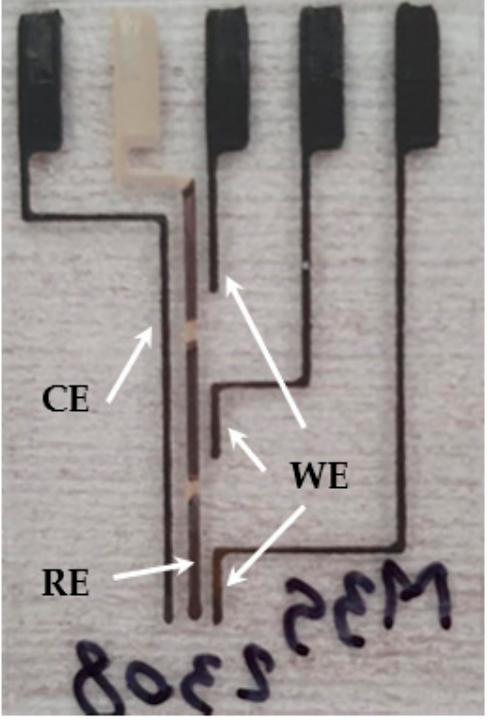
Figure 3. Electrochemical sensor array with 3 carbon-based sensors on a rigid substrate (30 × 20 mm), with 5 electrodes: WEx3 and CEx1 were completely carbon-based, and REx1 was made from Ag/AgCl.